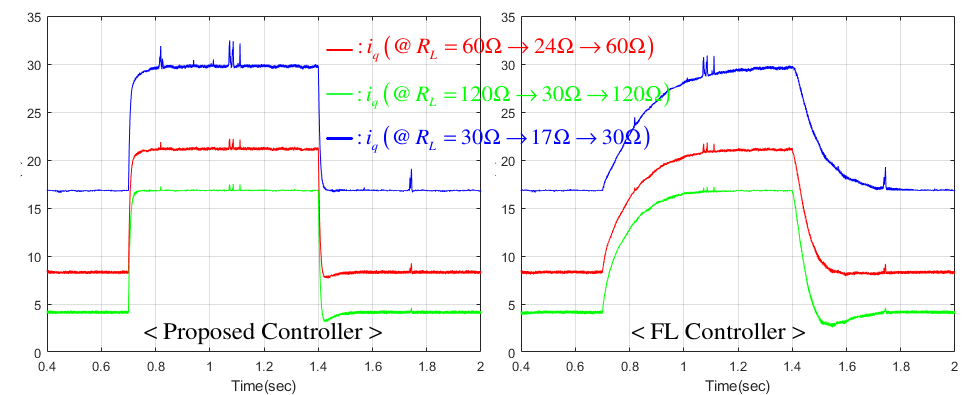
Figure 8. q -axis current response comparison under DC-link voltage regulation